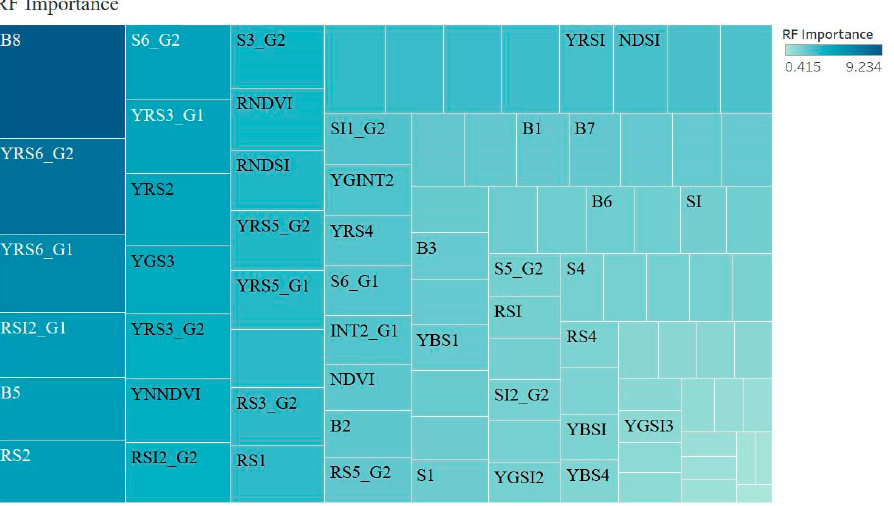
Figure 6. Random forest (RF) algorithm to determine the importance of the existing salinity index and the new salinity index.